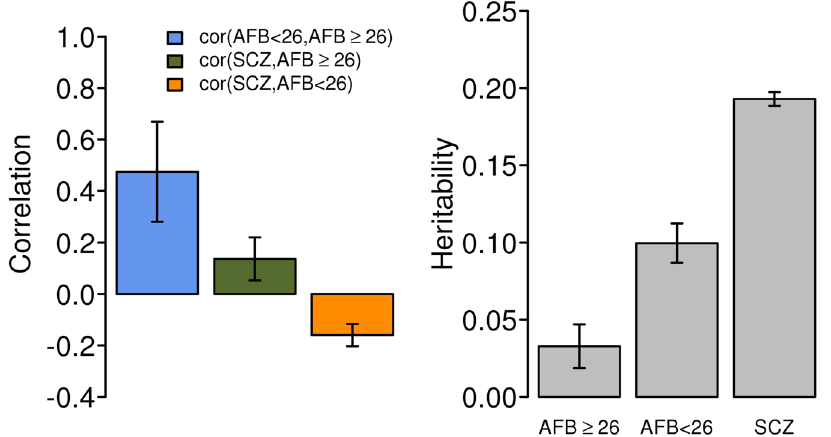
Figure 4. Genetic correlation (left) and heritability (right) of age at first birth (AFB) ≥ 26, AFB < 26, and schizophrenia (SCZ). Cor(AFB < 26, AFB ≥ 26): Estimated genetic correlation between the groups with AFB < 26 and with AFB ≥ 26. Cor(SCZ, AFB ≥ 26): Estimated genetic correlation between SCZ and AFB in the older AFB group. Cor(SCZ, AFB < 26): Estimated genetic correlation between SCZ and AFB in the younger AFB group. The bars are standard errors. In the model, the AFB phenotypes were adjusted for age at interview, year of birth, assessment center at which participant consented, genotype batch and the first 20 principal components. And the SCZ phenotypes were adjusted for sex, cohorts and the first 20 principal components. The sample size for group AFB ≥ 26 was 17,598 and for group AFB < 26 was 21,294, and for group SCZ was